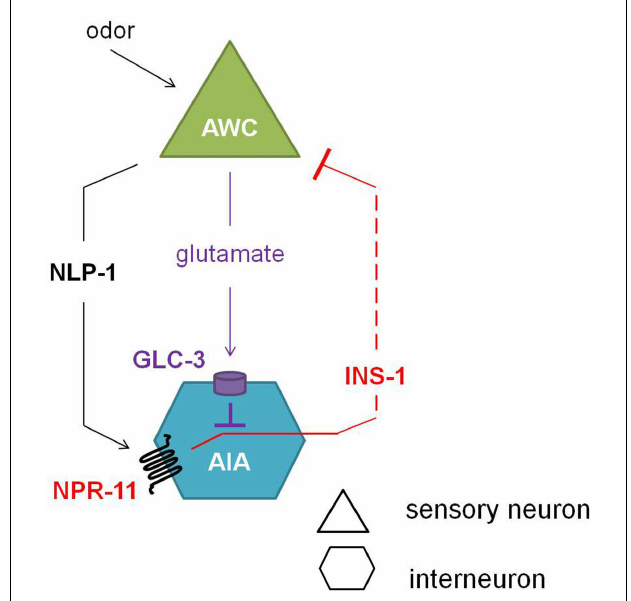
FIGURE 5 | Neuropeptide feedback regulation of theAWC sensory neurons. The AIA interneurons are inhibited via the glutamate-gated chloride channel GLC-3 upon release of the neurotransmitter glutamate from the AWC neurons. Alternatively, when odor is sensed, the AWC neurons release NLP-1, which in turn activates NPR-11 on the AIA interneurons. Upon activation of NPR-11, INS-1 is released, inhibiting AWC activity and thereby reducing its inhibition on AIA (adapted from Chalasani et al.,